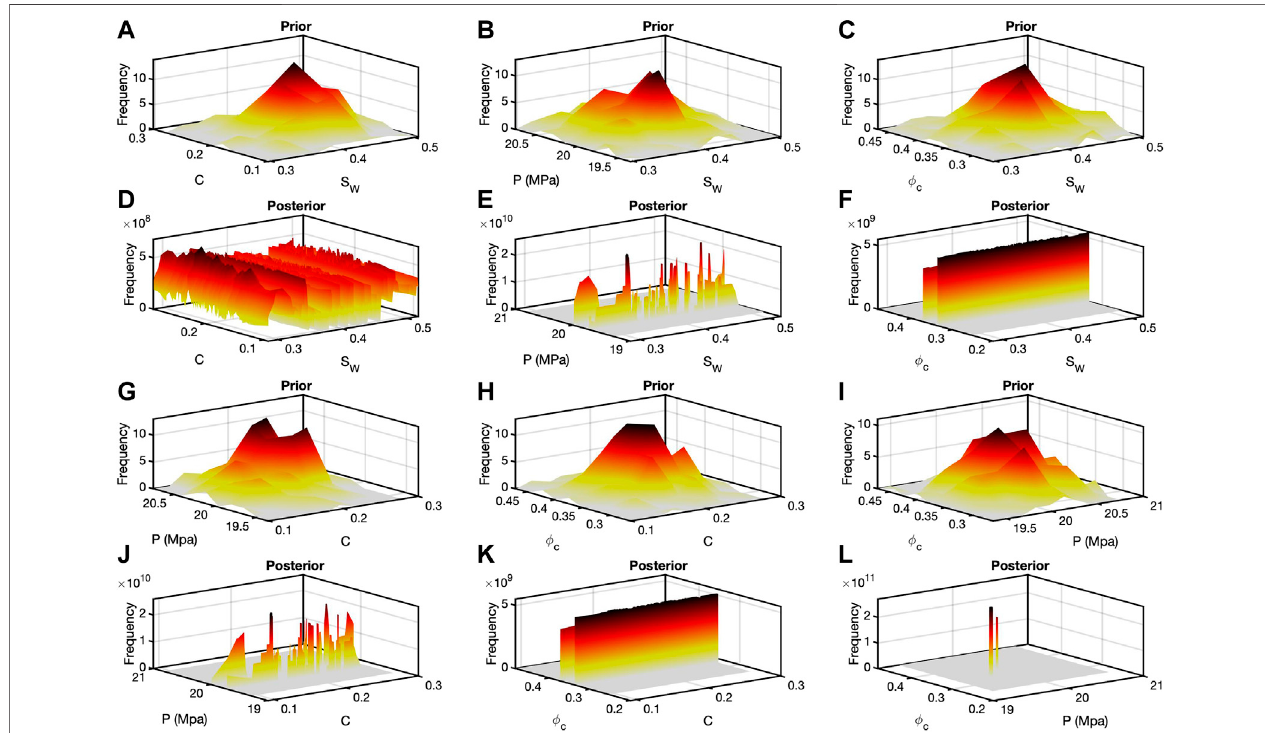
FIGURE 5 | Bivariatehistogramsforanalysisone.Plots (A – C) arethebivariatepriorhistogramsfor C − S w , P - S w ,and ϕ c − S w ,respectively.Plots (D – F) containtheposterior histograms corresponding to the priors in (A – C) . Priors for P-C , ϕ c − C , and ϕ c − P are in (G – I) with their corresponding posteriors in (J – L) . When many pairs in a posterior occur together,suchasin (D) ( C − S w )thatindicatesrelativeinsensitivitytothosetwovariables.Countertothatis (L) whereisolatedpairsof ϕ c and P occurtogetherinevenlargernumbers.